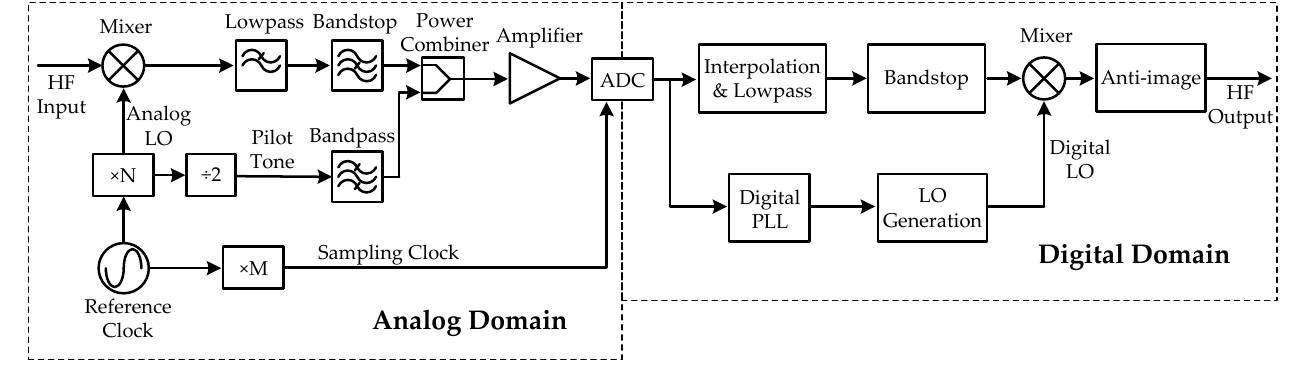
Figure 5. Pilot tone insertion